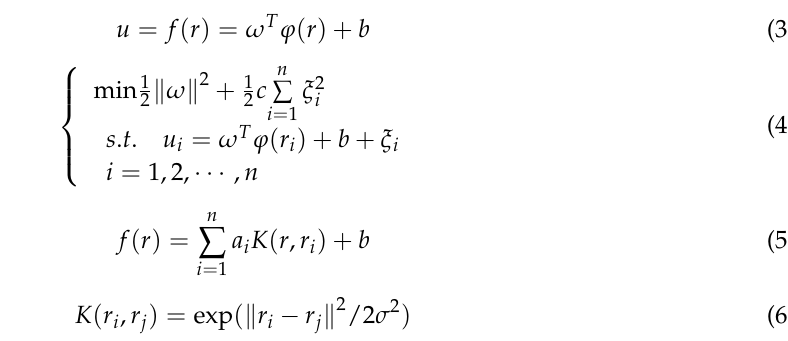
(Figure 1) between the objective function value vector r i and